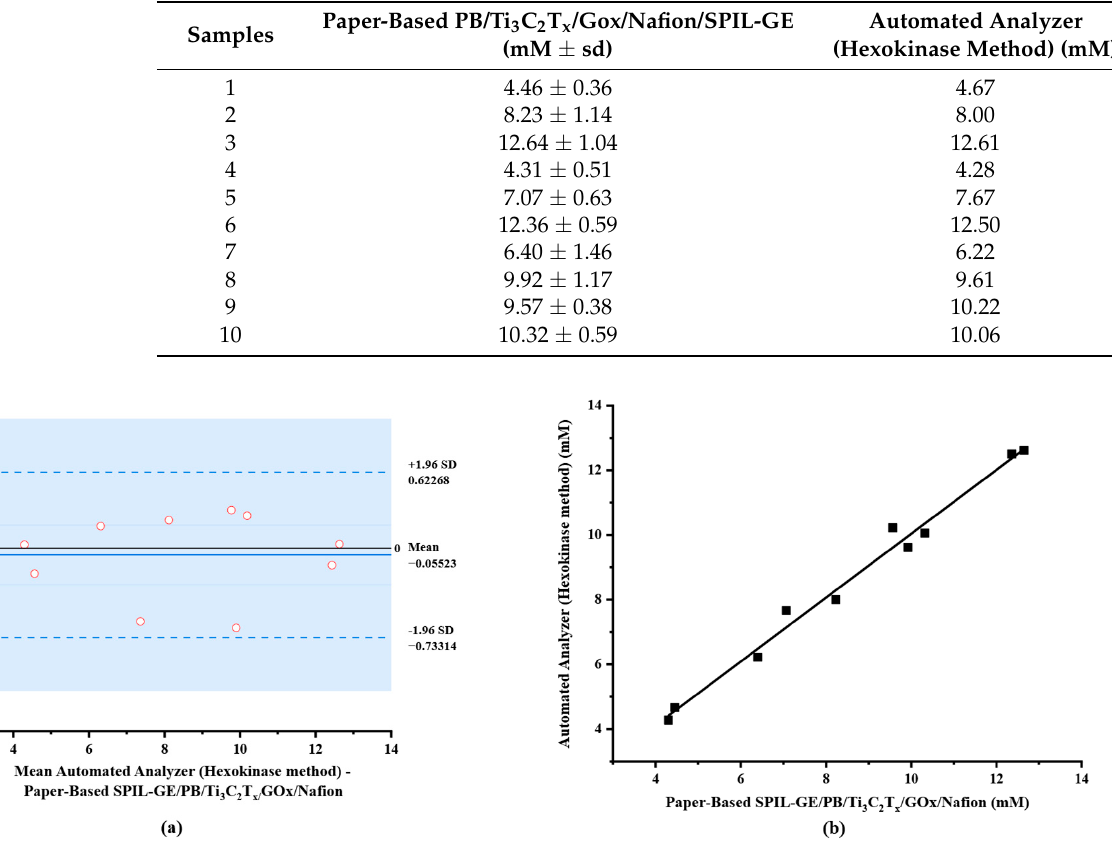
Figure 7. Comparison of electrochemical method using paper-based PB/Ti 3 C 2 T x /GOx/Nafion/SPIL- GE and automated analyzer (Hexokinase method). ( a ) A Bland–Altman bias plot; ( b ) correlation plot.